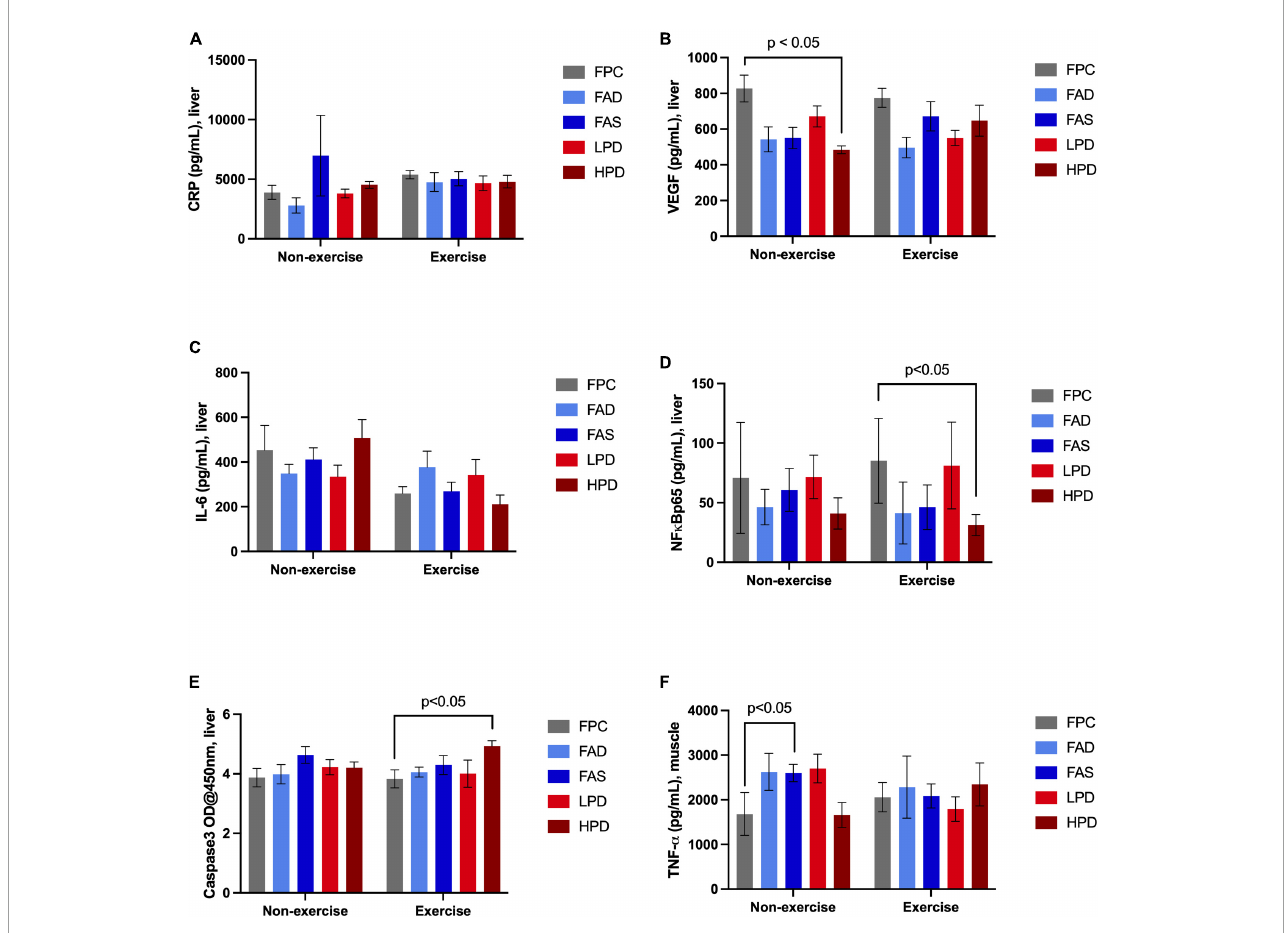
FIGURE4 Effect of dietary treatment and influence of exercise upon inflammatory biomarkers in liver and muscle in C57BL/6J mice. Liver concentration of (A) C-Reactive Protein (CRP, pg/mL); (B) Vascular Endothelial Growth Factor (VEGF, pg/mL); (C) Interleukin 6 (IL-6, pg/mL): (D) NF kappa ß p65, (pS536 + Total), pg/mL; (E) Caspase-3 (OD@450 nm); and, muscle concentration of (F) Tumor Necrosis Factor, (TNF- α , pg/mL). Mice were provided these 5 experimental diets: (1) 0 mg/kg folic acid FA/17.9% protein, TD.150200, FA Deficient (D) Diet (FAD; n = 16); (2) 2 mg/kg FA/17.9% protein; TD.150201, Control (C) FA Protein (P) Diet (FPC; n = 12); (3) 7 mg/kg, FA/17.9% protein; TD.15202, FA Supplemented (S) Diet (FAS, n = 16); (4) 2 mg/kg FA, 6% protein [Low Protein Diet (LPD, n = 16)]; and (5) 2 mg/kg FA/48% protein [High Protein Diet (HPD, n = 16)]. The results are means ∼ + SEM ( n = 8). Panel (B) VEGF p < 0.05, exercised FPC vs. HPD; panel (D) NF kappa ß p65 p < 0.05, exercised FPC vs. HPD; panel (E) Caspase-3 p < 0.05, exercised FPC vs. HPD; and, panel (F) muscle TNF- α , unexercised FPC and FAS, p <